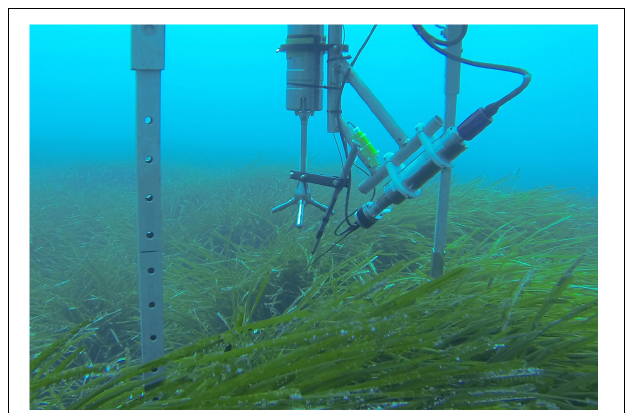
FIGURE 1 | Eddy covariance instruments at the open-water seagrass meadow at Elba, Italy in May of 2016. The velocimeter is upright, in titanium, with three receivers aligned toward the measurement volume. Aligned beside the measurement volume are a prototype sensor (results not included in this study), and the pencil-sized eddy covariance oxygen minisensor.